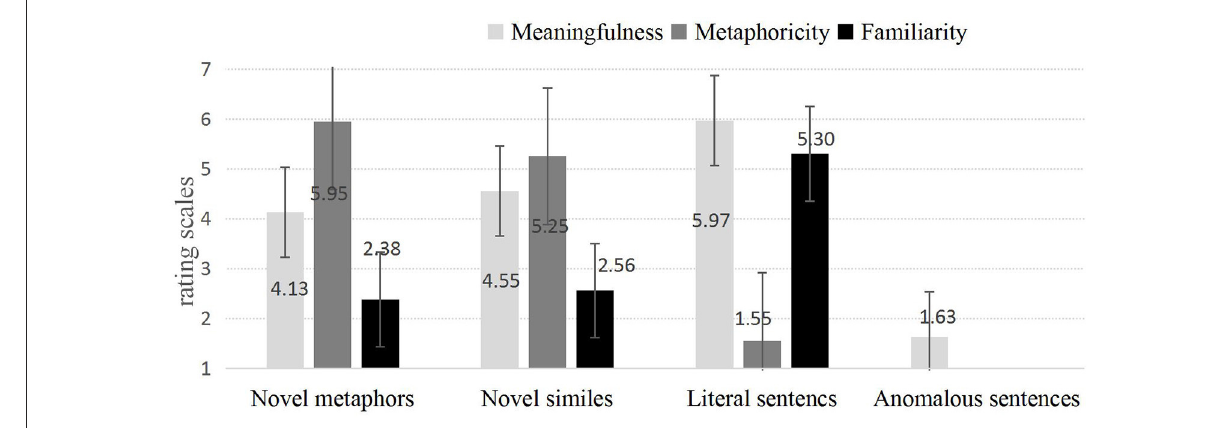
FIGURE1 Meaningfulness, familiarity and metaphoricity ratings for novel metaphors, novel similes, literal, and anomalous sentences.